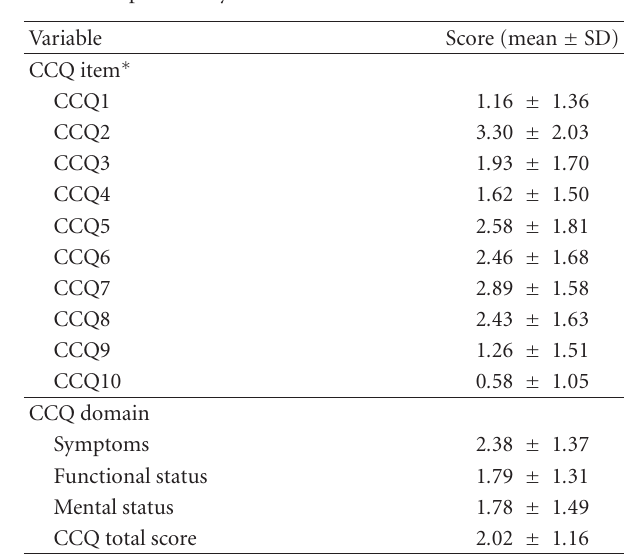
Table 3: Scores of Clinical COPD Questionnaire score (CCQ) and those of its components in 89 patients with clinically stable chronic obstructive pulmonary disease.